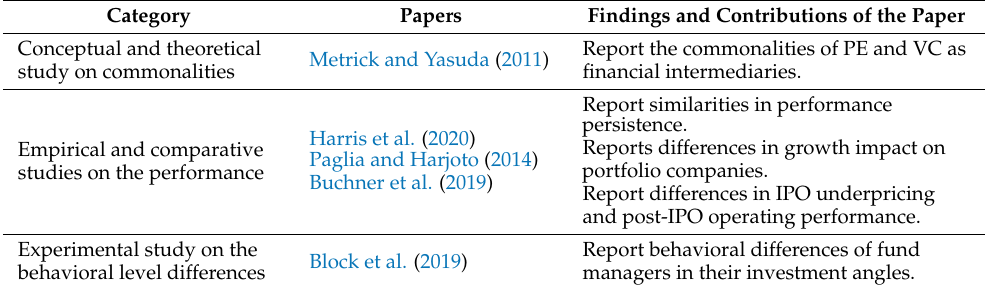
Table 1. Summary of the previous literature on differences and intersections between PE and